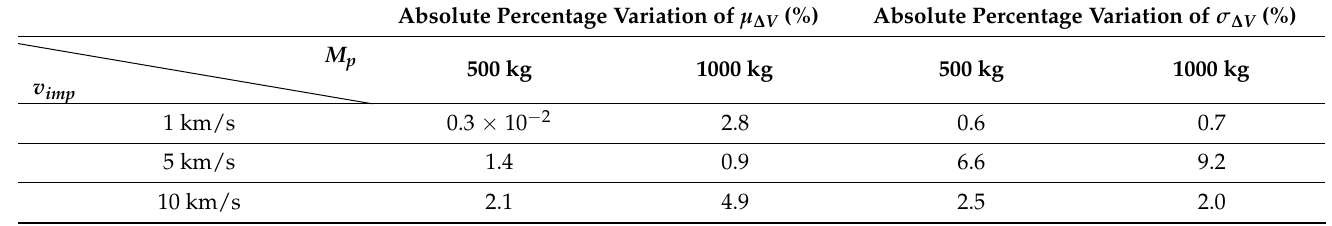
Figure 3. Mean ( a ) and standard deviation ( b ) of velocity distribution of sample fragments for different values of target mass for an impact velocity of 10 km/s. Mass of projectile is assumed to be 100 kg. Table 1. Absolute percentage variation of μ Δ V and σ Δ V distributions for target mass equal to 500 kg and 1000 kg with respect to target mass equal to 100 kg.